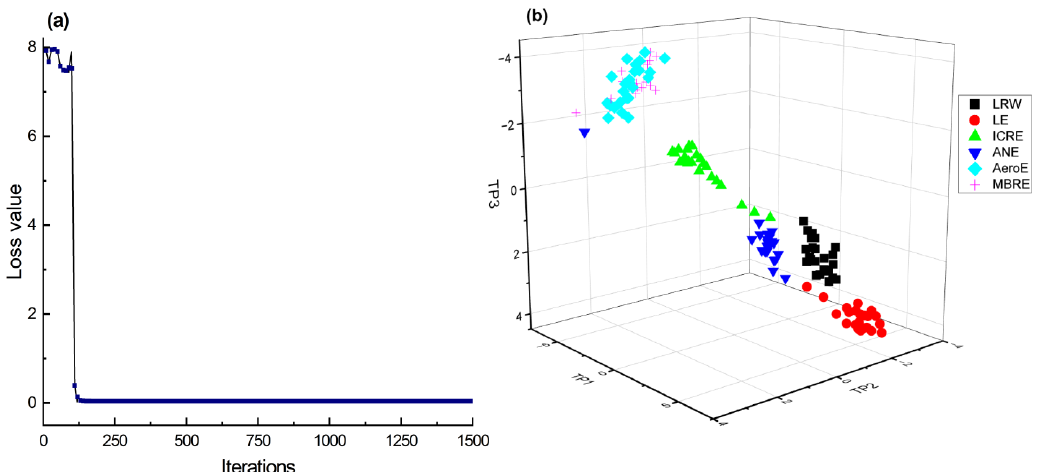
Figure 5. Visualization of e-nose data dimensionality reduction based on TNSE: ( a ) the loss value according to iteration; ( b ) sample distribution based on the first three TPs.